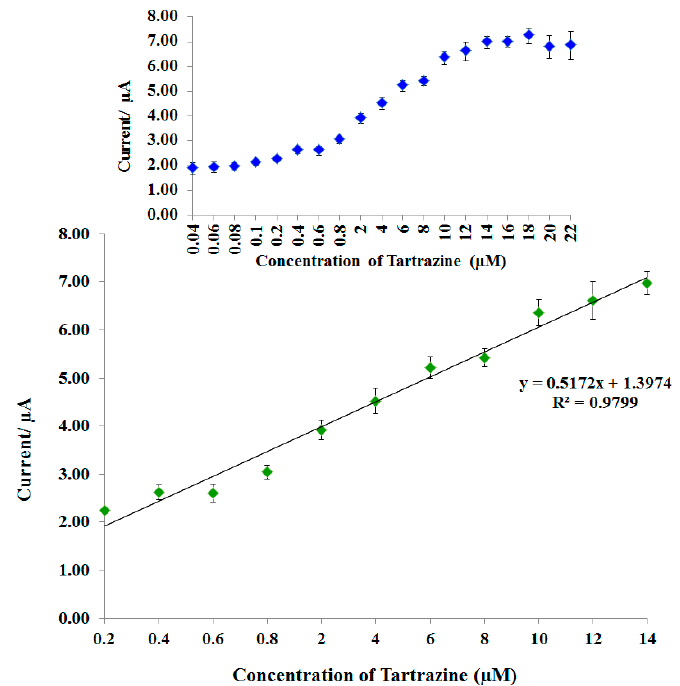
Figure 6 . Calibration curve of the anodic peak currents as a function of Tartrazine concentrations in PBS (0.1 M, pH 5.0). Inset: Effect of concentration of Tartrazine solution. Accumulation time: 120 s; Error bar represents the standard deviation of triple measurements.